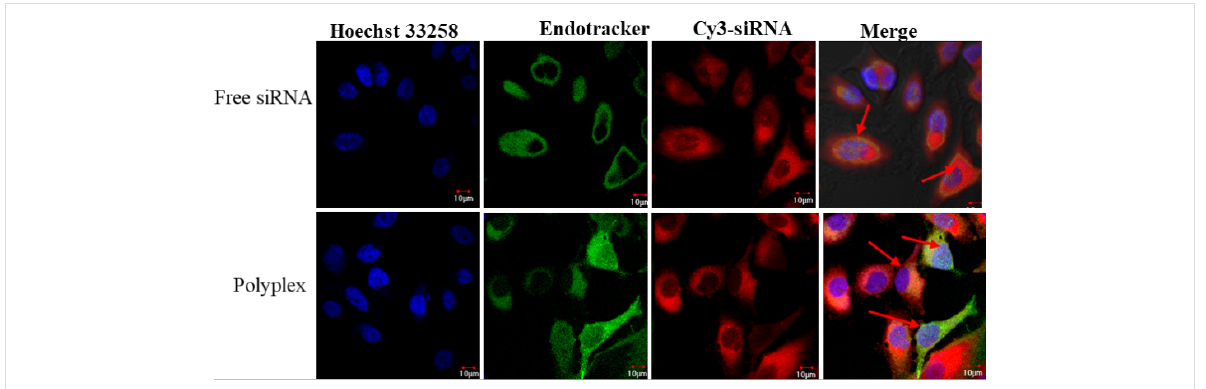
Figure 4: The endosomal escape of the polyplex after 4 h of incubation in A549 cells visualized using endotracker (stains early endosomes green) and the red fluorescence from Cy-3 labeled siRNA observed with confocal laser scanning microscopy. The co-localization of the Cy3-labeled siRNA and endosome is observed as yellow fluorescence (red arrows). The green emission was recorded at 488 nm while the red emission was captured at 568 nm. The blue fluorescence of Hoechst 33258 was recorded at 405 nm.